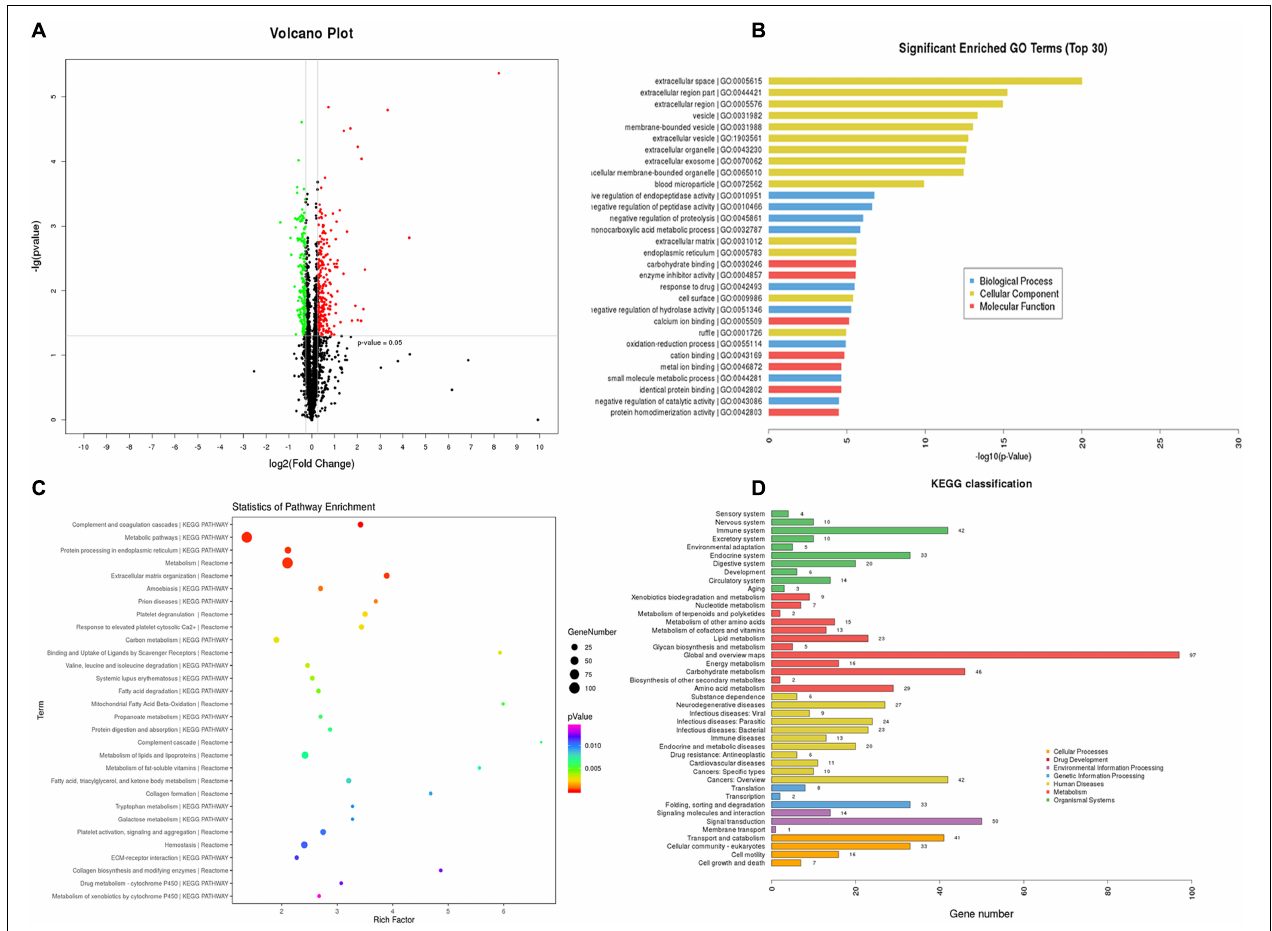
FIGURE 3 | TMT-proteomics analysis of ISO group compared with the Sham group. (A) The Volcano Plot of differentially expressed proteins (DEPs) identified between ISO group and Sham group. Red dots represent upregulated DEPs; green dots represent downregulated DEPs; black dots represent unchanged proteins. (B) The top 30 significantly enriched GO terms for the DEPs identified between ISO group and Sham group using biological process, cellular component, and molecular function. (C) Statistics of pathway enrichment for the DEPs identified between ISO group and Sham group. (D) Classification of the enriched KEGG pathways for the DEPs identified between ISO group and Sham